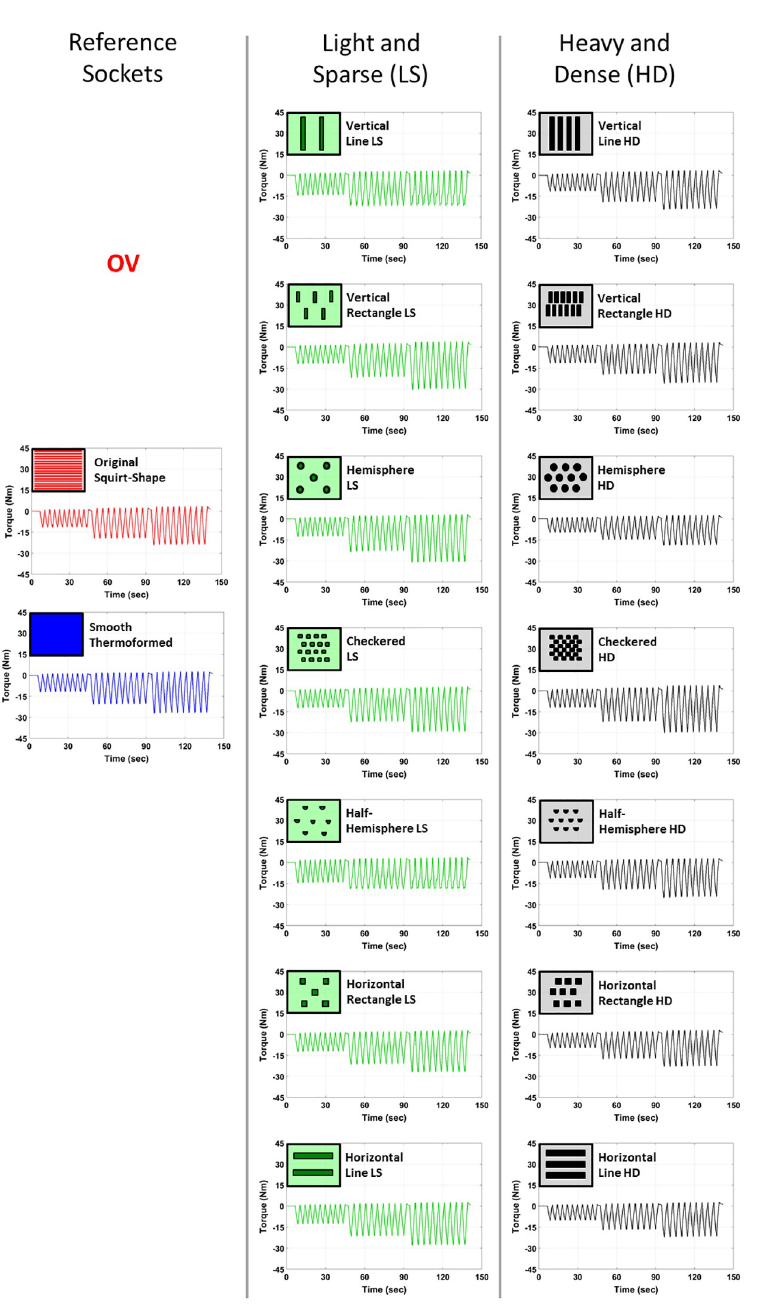
Fig 5. Mean torque for passive suction suspension with one-way valve